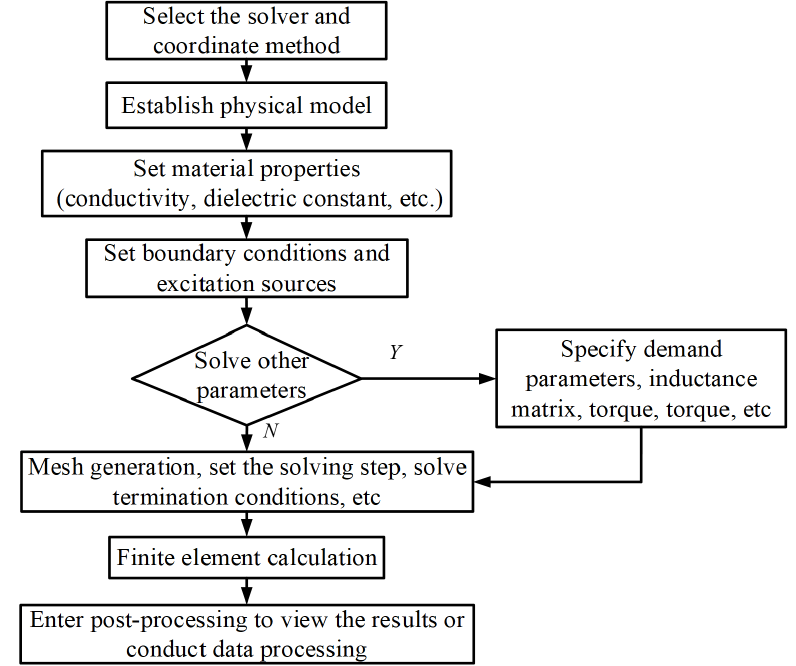
Figure 1. Ansoft Maxwell 3D electromagnetic field solution flow